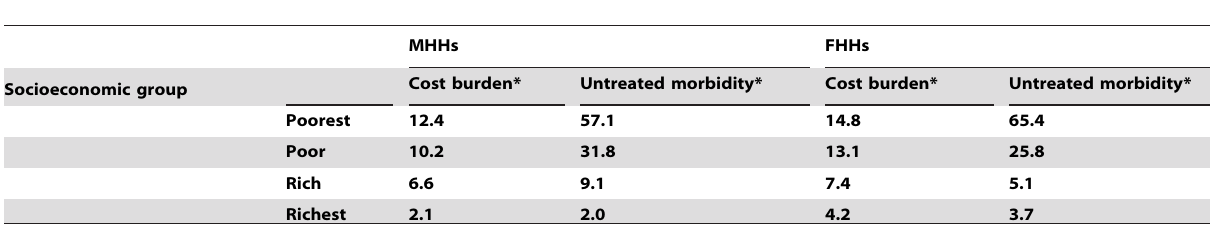
Table 3. Distribution of health care costs burden and untreated morbidity across socioeconomic groups.